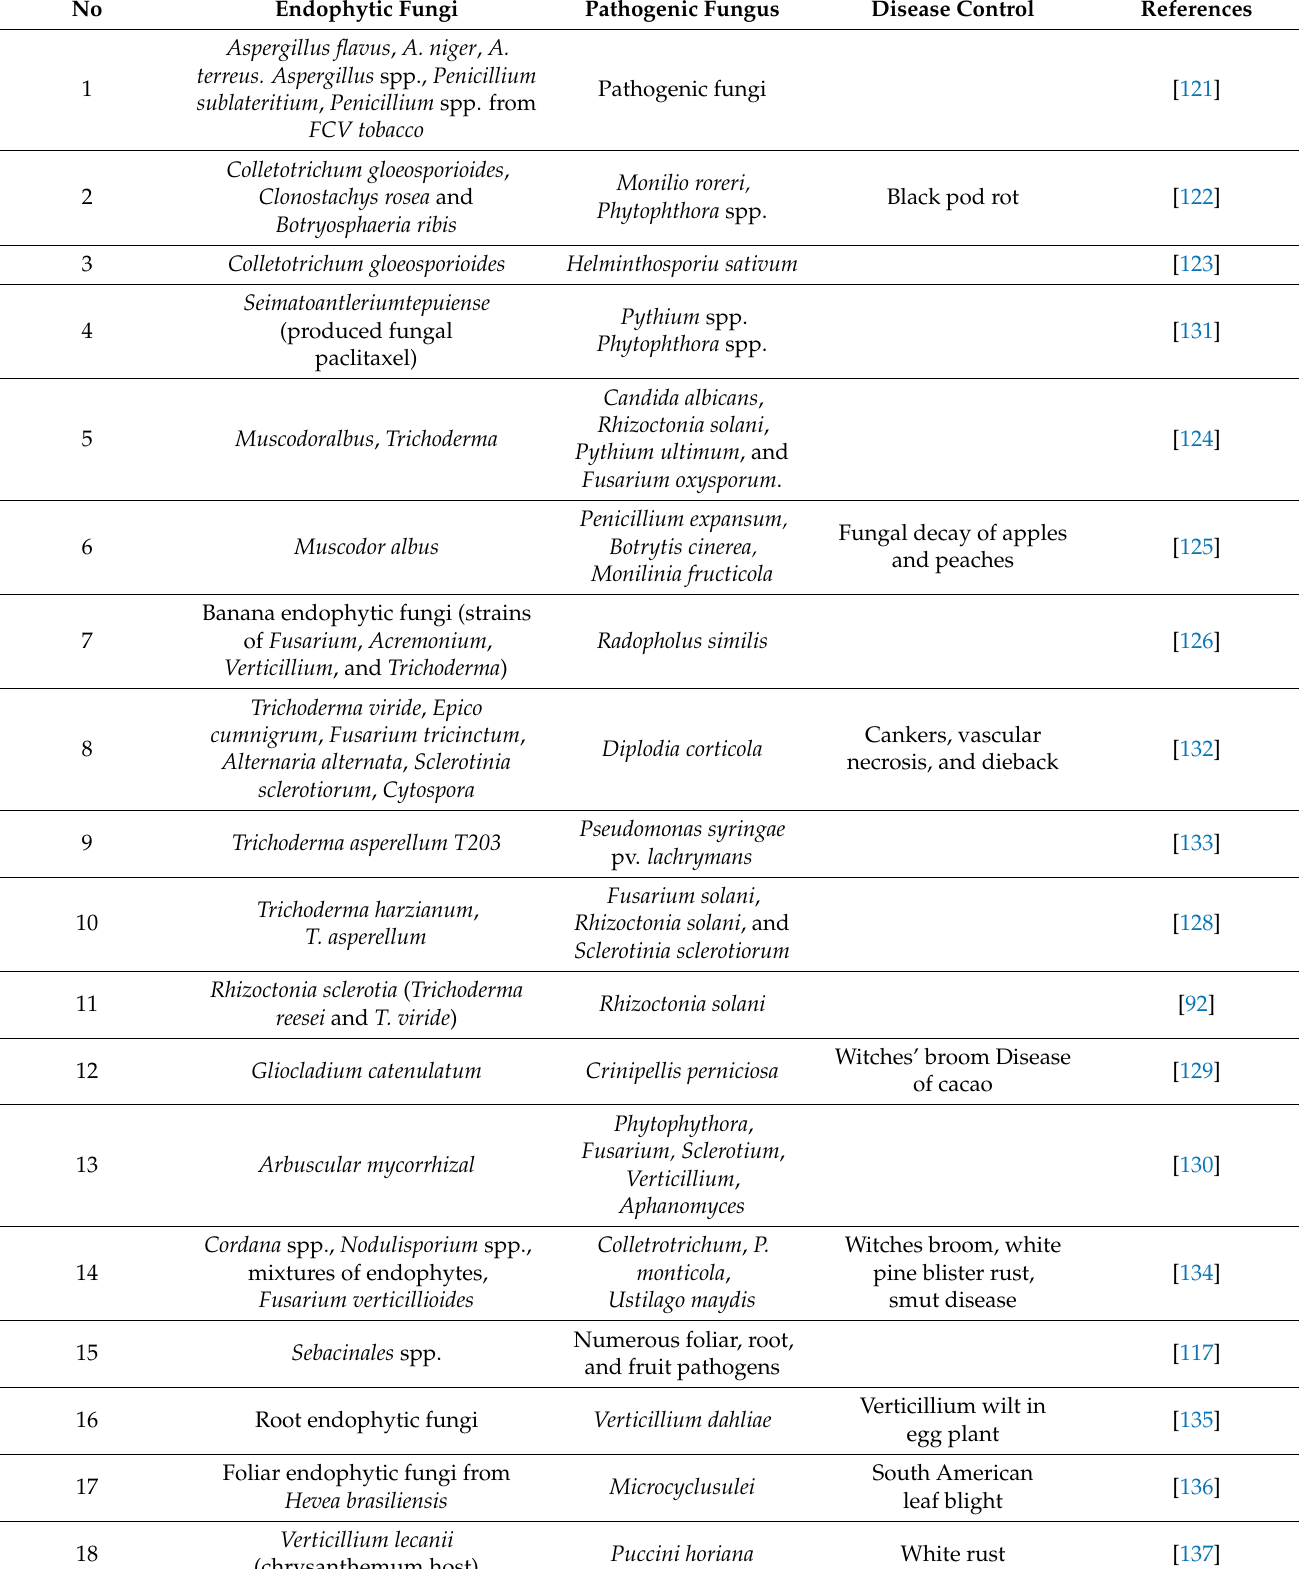
Table 1. Fungal endophytes as biological control agents against pathogenic